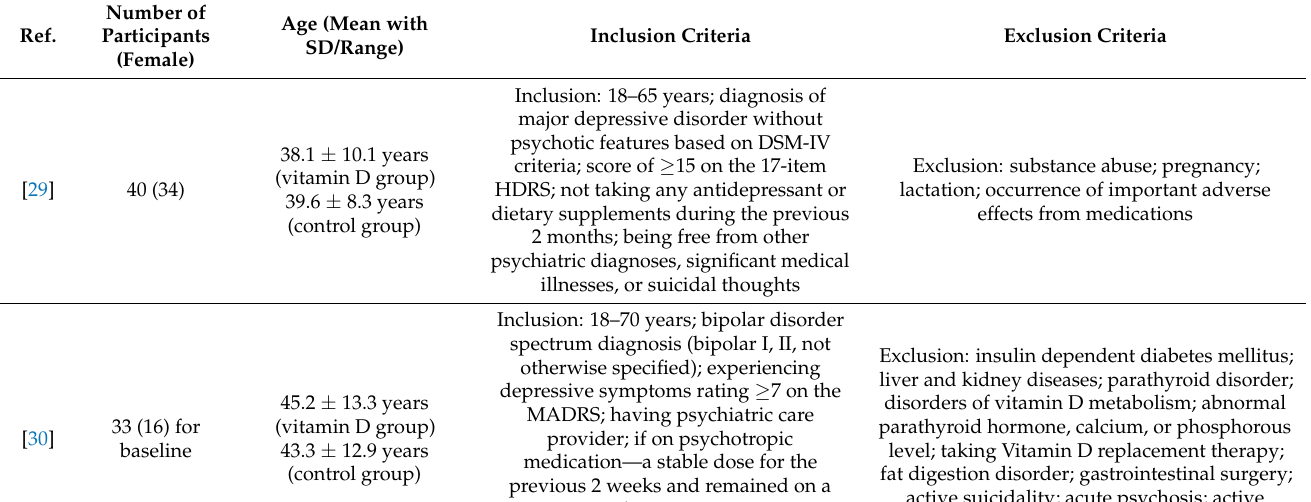
Table 3. The descriptions of the studied populations within studies included to a systematic